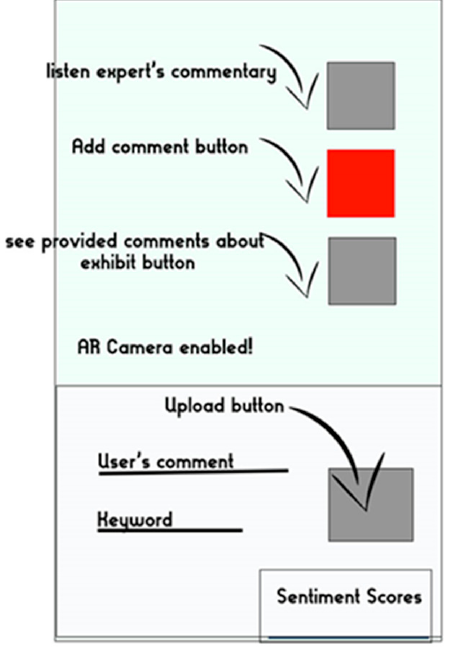
Figure 1. George Hein’s diagram classifying learning and knowledge theories (Hein, 2002, p. 25).